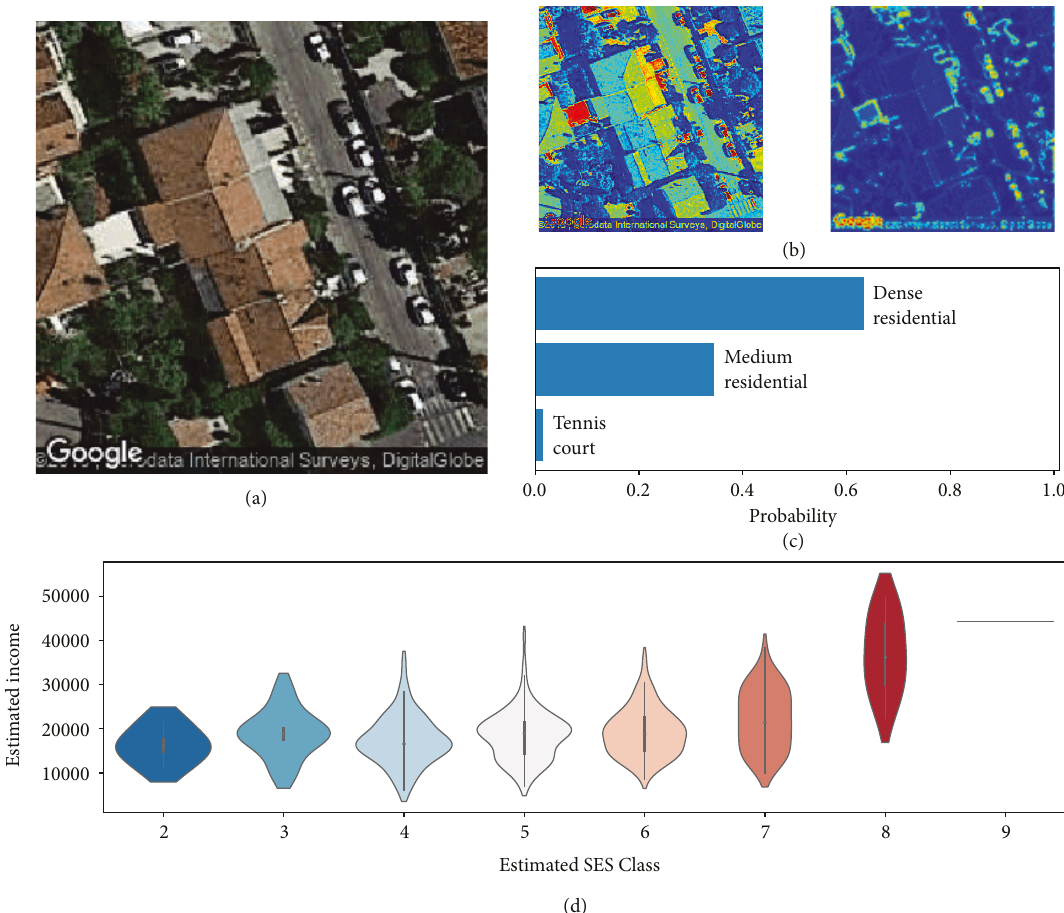
Figure 5: Top: ResNet50 Output: (a) original satellite view; (b) first two hidden layers activation; (c) final top-3 most frequent predicted area types; (d) architect SES score agreement with census median income for the sampled home locations. It is shown as violin plots of income distributions for users annotated in different classes (shown on x-axis and by